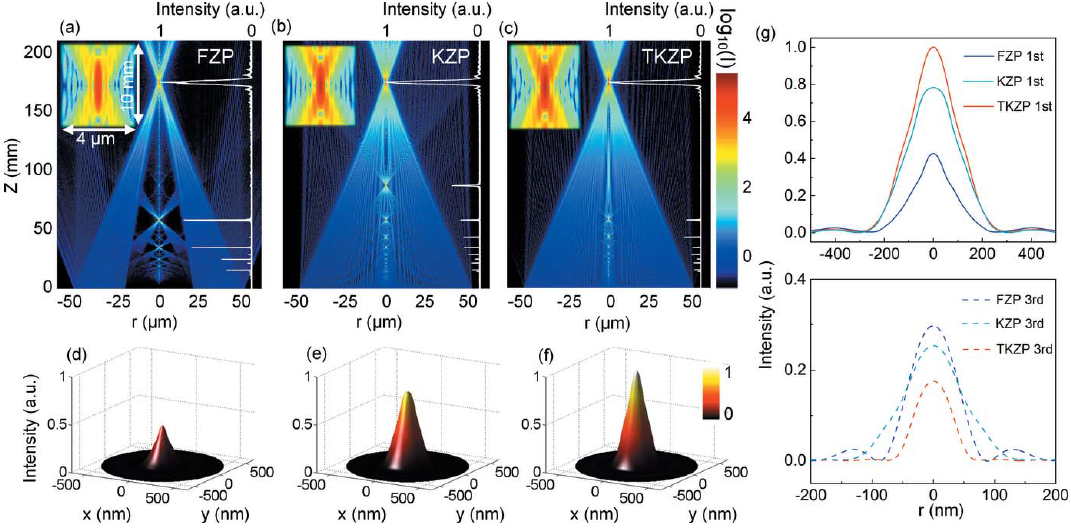
Figure 2 The focusing properties through the binary FZP ( a , d ), KZP ( b , e ) and TKZP ( c , f ) are numerically calculated by our BPM-QDHTapproach for an X-ray energy of 8 keV. The lenses have a focal length of 161 mm at 8 keV with diameter of 100 m m and outermost zone width of 500 nm. The thickness t of both the KZP and TKZP is 1.8 m m, and is 1.5 m m for the FZP to obtain the best efficiency. ( a – c ) The 2D intensity (on logarithm scale) of the propagated wavefield created by three different types of zone plate lenses. In the insets, the 1D curves (white lines) are the normalized intensity distribution along the axis. ( d – f ) The normalized 3D surface profile of the first-order focus intensity of three different types of zone plate lenses. ( g ) The normalized intensities of the first-order focal spots and the third-order focal spots of the three lenses. (All the design parameters are given in Table S1 of the supporting